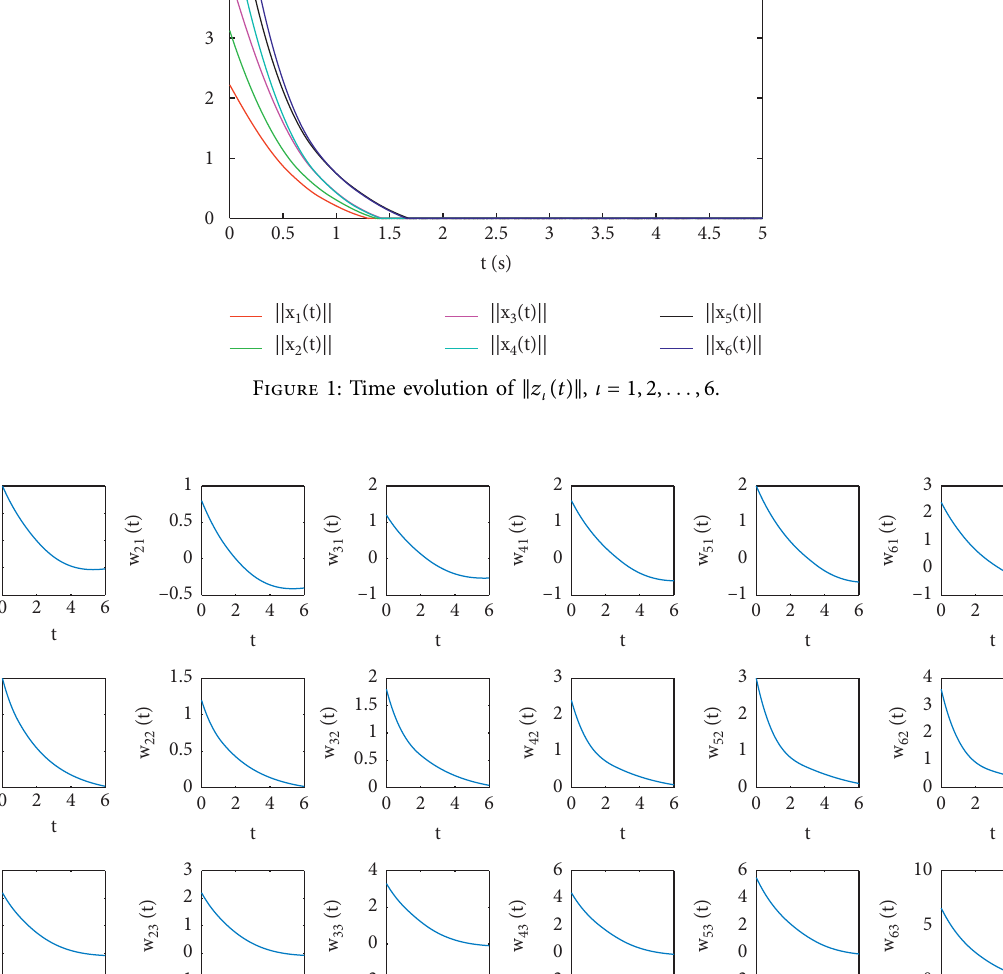
Figure 2: Te single dynamical change process of uncoupled NN in